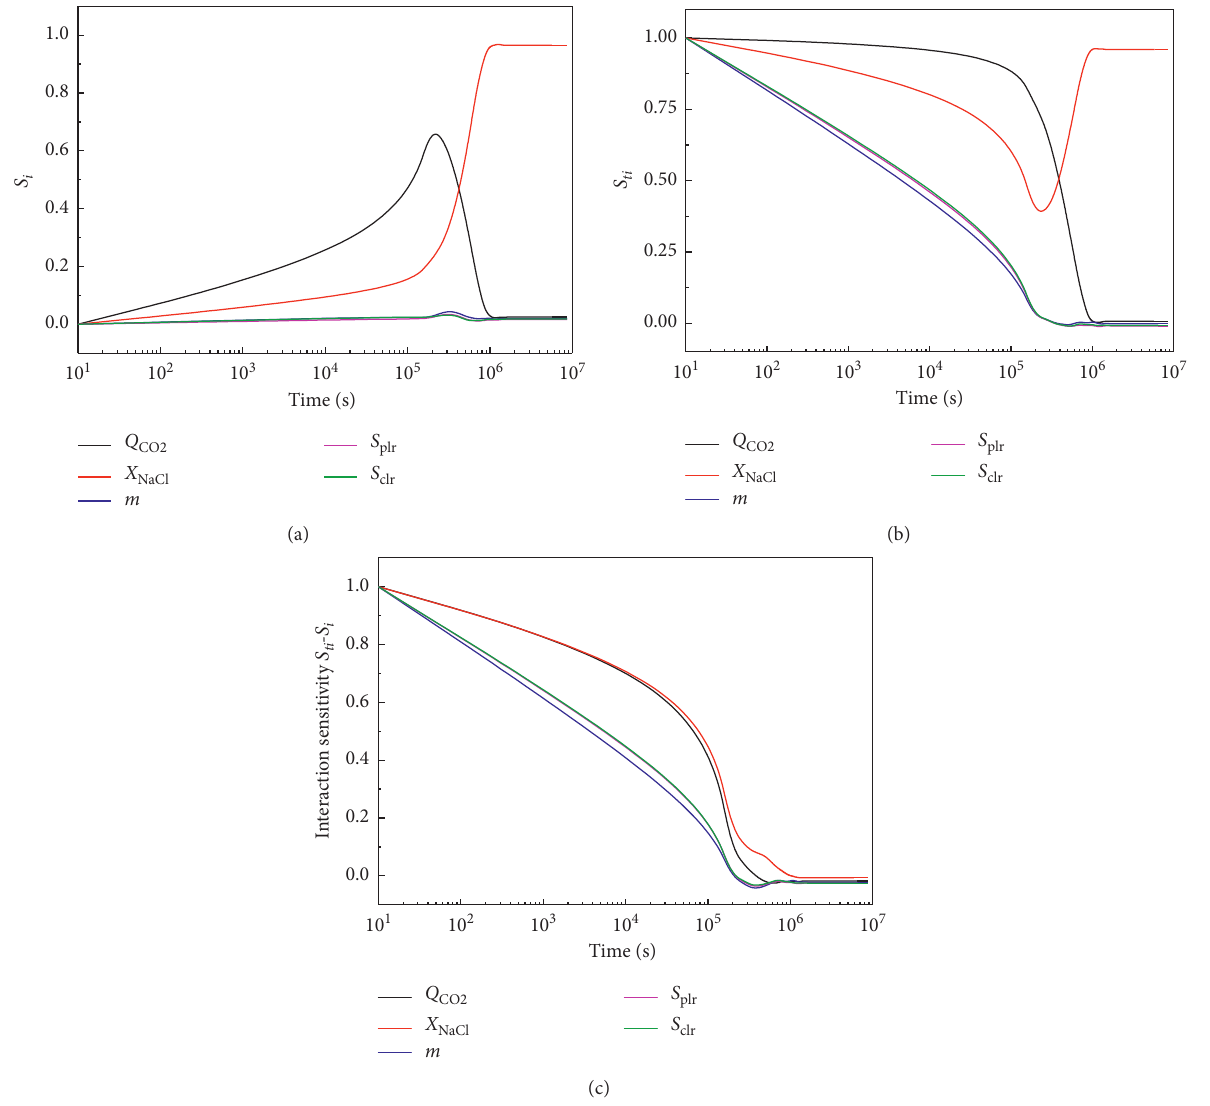
Figure 12: Time evolution of the sensitivity index: (a) S